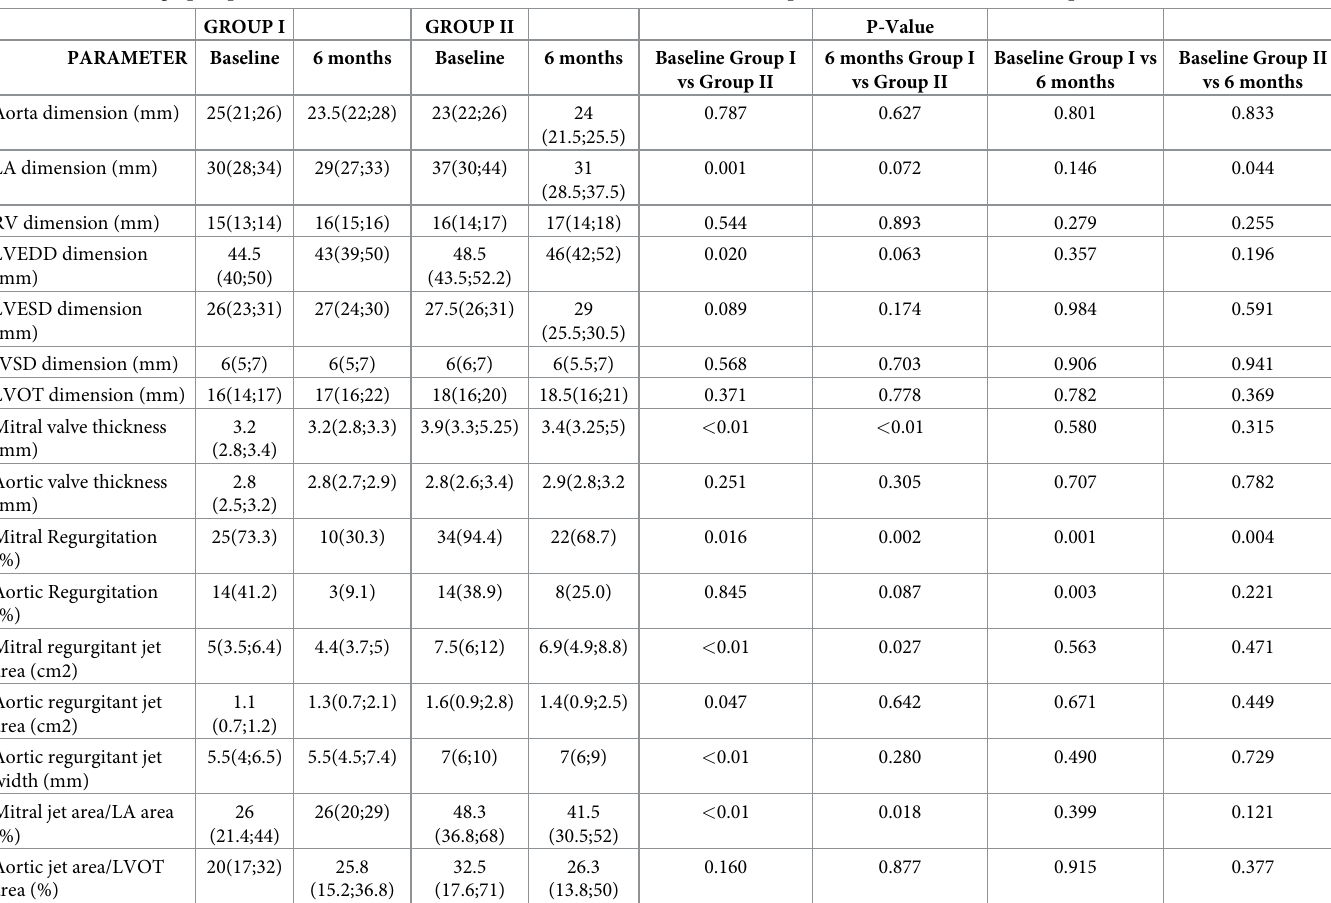
Values are shown with statistical differences between Group I (individuals who did not developed Rheumatic Heart Disease) and Group II (those who developed Rheumatic Heart Disease) at distinct